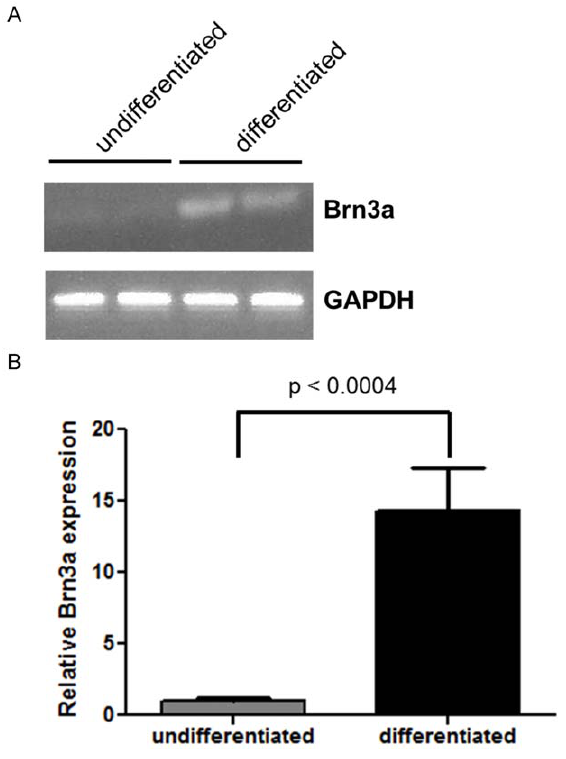
Figure 3. Brn3a expression is increased in differentiated iPS cells. RT-qPCR of Brn3a and GAPDH mRNA was performed. (A) Gel electrophoresis of Brn3a and GAPDH expression in undifferentiated and differentiated iPS cells. The PCR products obtained after 34 cycles was run on a 3% agarose gel. (B) The relative Brn3a gene expression in undifferentiated and differentiated iPS cells (unpaired t test, p , 0.0004). Data shown are mean 6 SEM of three biological replicates.